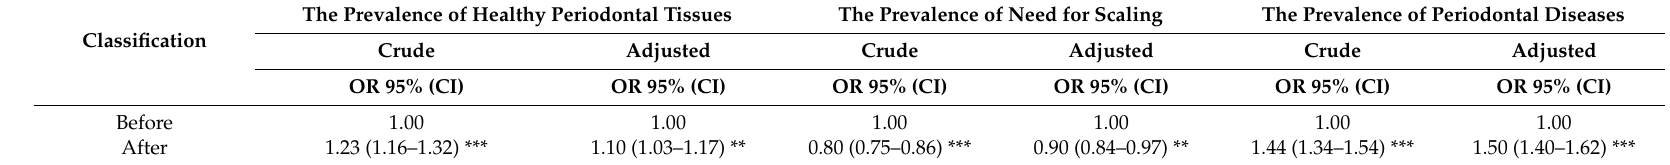
Table 5. Association between insurance coverage implementation and periodontal